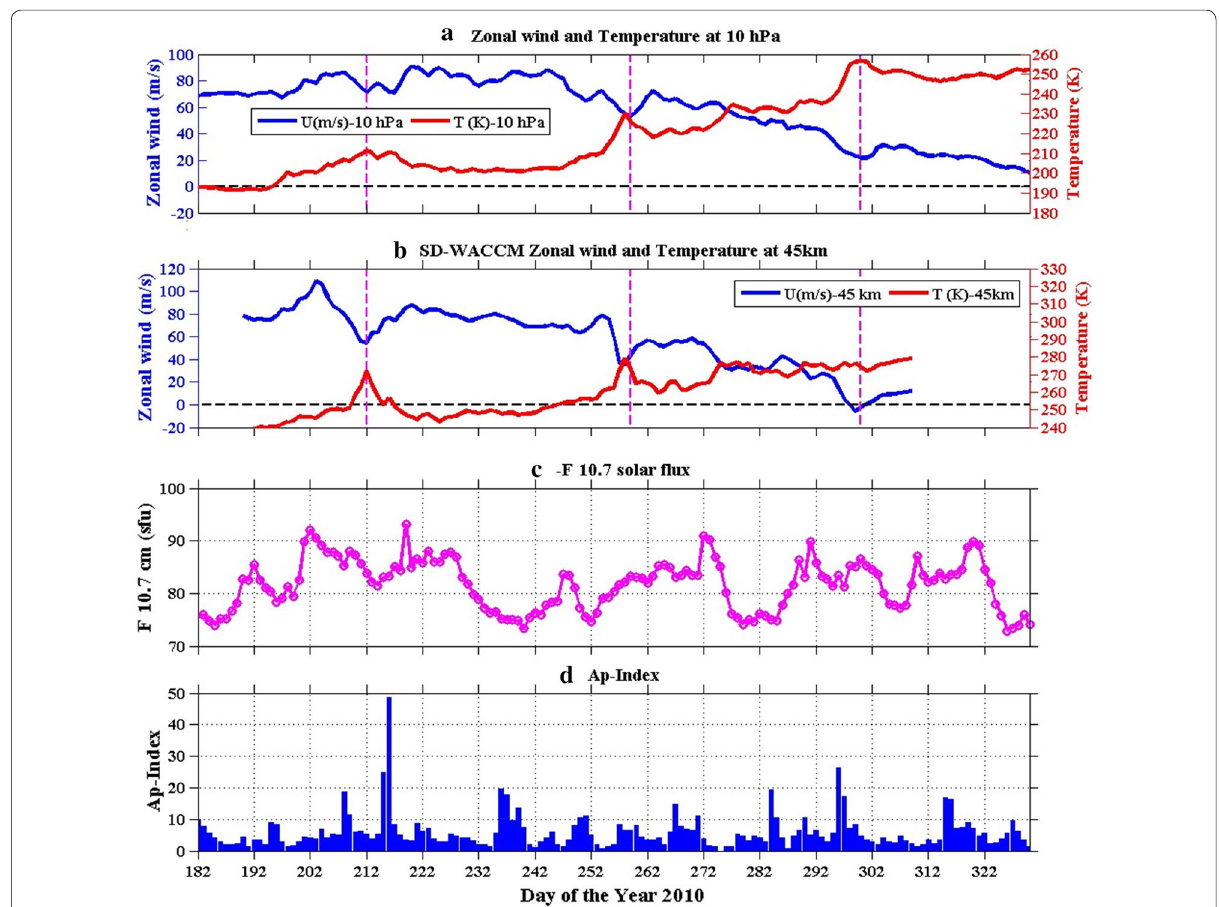
Fig. 1 a Zonal mean zonal winds ( blue line ) at 60°S and zonal mean temperatures ( red line ) at 80°S derived from ECMWF dataset during 2010 SH winter. The temperature scale is given on the right side. Vertical dashed lines indicate the day of peak warming. Dashed horizontal line indicates the zero wind level. b Same as a but using SD-WACCM simulations and are zonal mean values at 45 km. c Daily mean variability of F 10.7 cm solar flux. d Daily mean variability of Ap